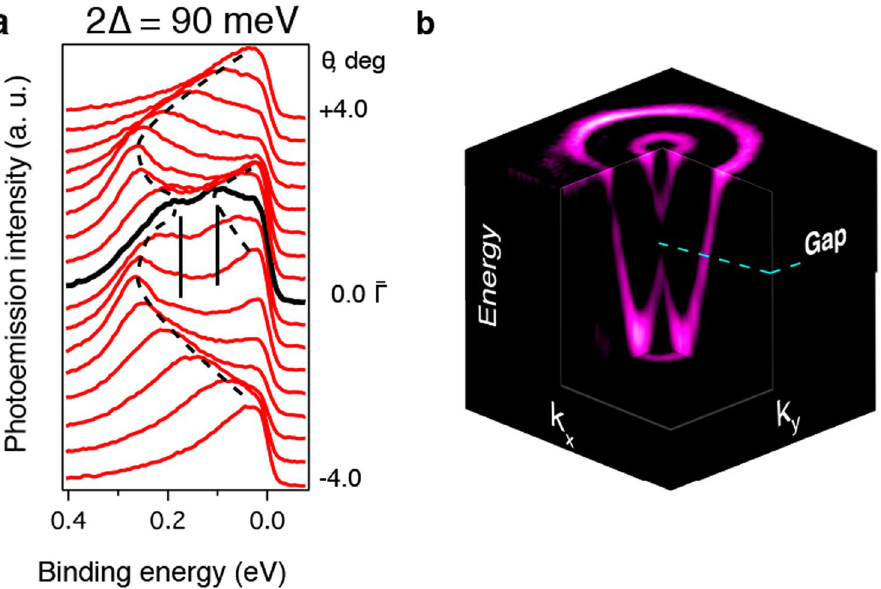
Figure 2. Detailed insight into the exchange gap spectral structure. ( a ) Raw ARPES data for Bi 0.985 V 0.015 TeI taken at 20 K, extracted from the data presented in Fig. 1f. ( b ) Three-dimensional dispersion relation of the Bi 0.985 V 0.015 TeI Rashba-split exchange-gapped surface state at 20 K (the second derivative is